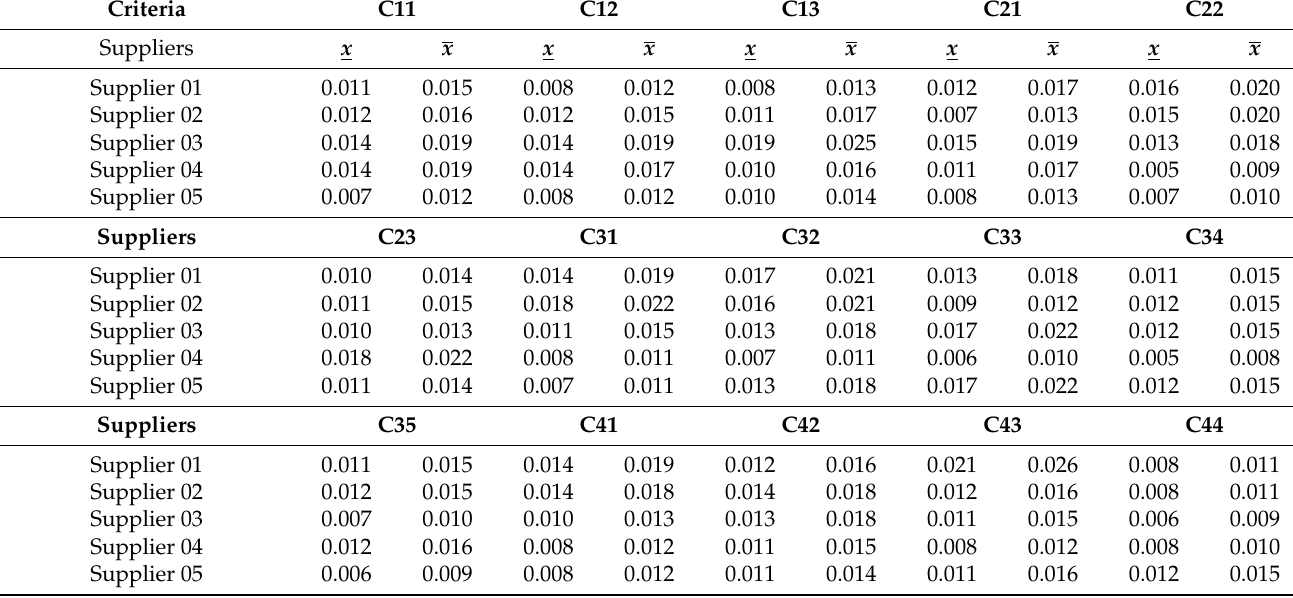
Table A3. The weighted normalized grey decision matrix of